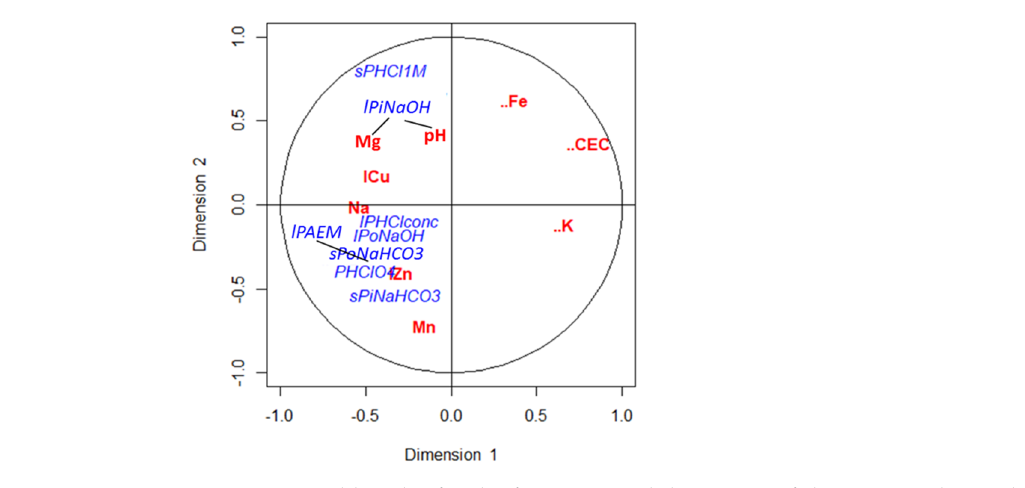
Figure 5. Variables plot for the first canonical dimension of the Canonical Correlation Analysis performed to the P fractions and the chemical fertility-related parameters. Abbreviations for soil parameters as in Table S2.